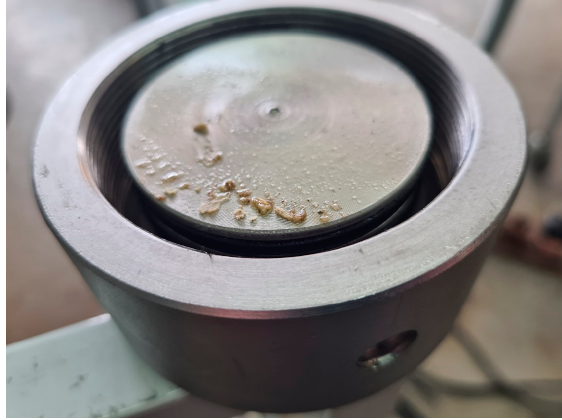
Figure 5. Extract discharge at 8 MPa, no US.